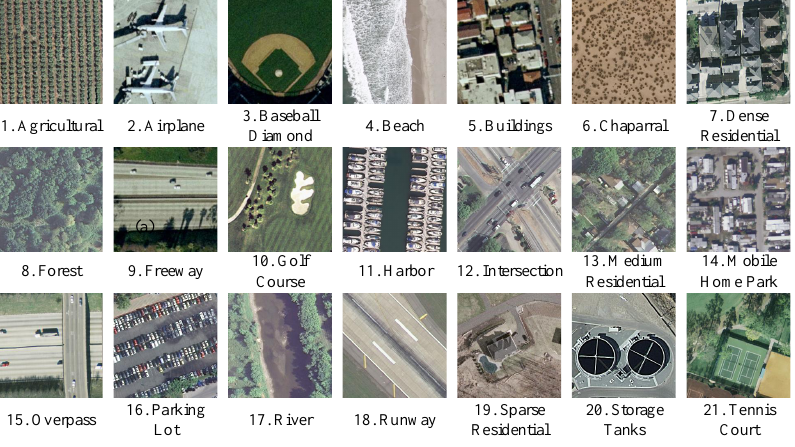
Figure 9. Examples of